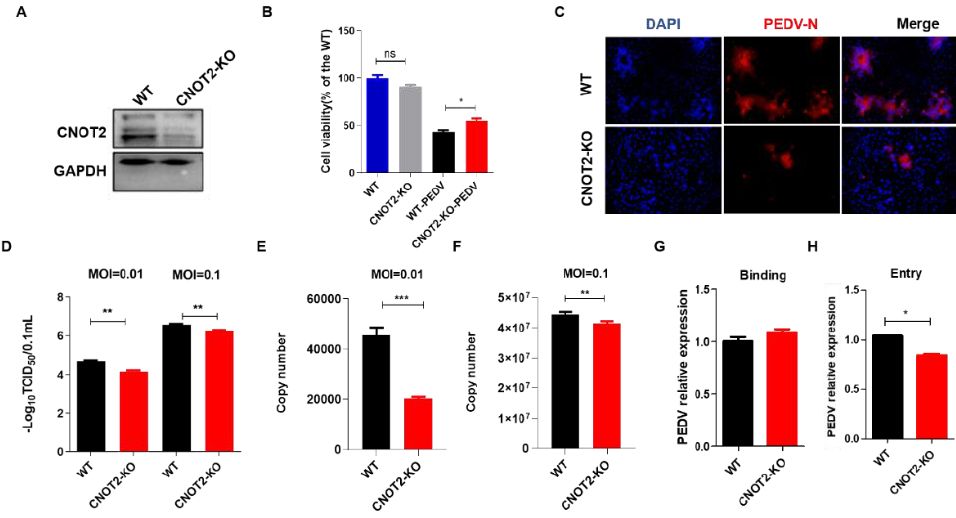
Figure 2. Effect of CNOT2 on PEDV infection of Vero cells. ( A ) Western blot was performed in CNOT2 KO and WT Vero cells. ( B ) Cell viability was evaluated by CCK-8 assay. All the values were normalized to the WT group, representing 100% cell viability. WT and CNOT2-KO cells were infected or uninfected with PEDV for 36 hpi at 0.01 MOI. ( C ) WT and CNOT2 KO cells were infected with 0.01 MOI PEDV at 36 hpi for immunofluorescence analysis with PEDV-N. ( D – F ) WT and CNOT2 KO cells infected with PEDV (0.01 and 0.1) at 36 hpi; whole cell lysates (WCLs) and RNA harvested TCID50 ( D ) and the absolute quantification qRT-PCR ( E , F ), respectively. ( G , H ) WT and CNOT2-KO infected with PEDV at MOI of 5 for 1 h at 4 ◦ C (binding) and warmed to 37 ◦ C for 30 min to initiate entry. The binding and entry of PEDV were quantitated by RT-qPCR; viral RNA was harvested for absolute qRT-PCR. All of the experiments were independently performed three times. Data are represented as means ± S.D.; ns: not significant. p -values are determined by two-sided Student’ s t -test, * p < 0.05; ** p < 0.01; *** p < 0.001.